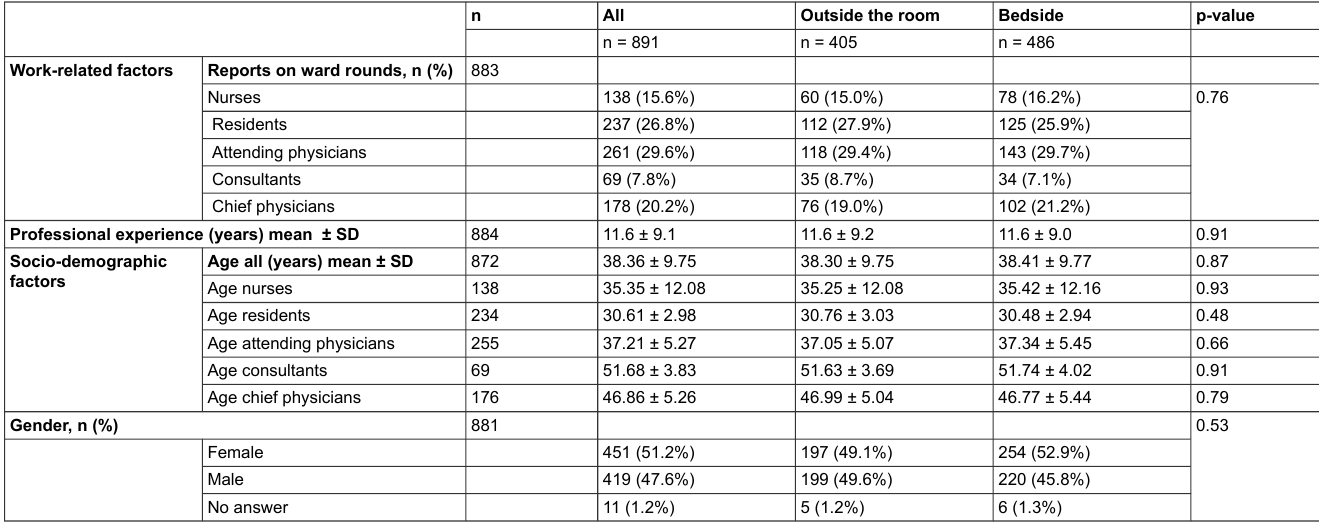
Table 1: Characteristics of the participants stratified by location of ward